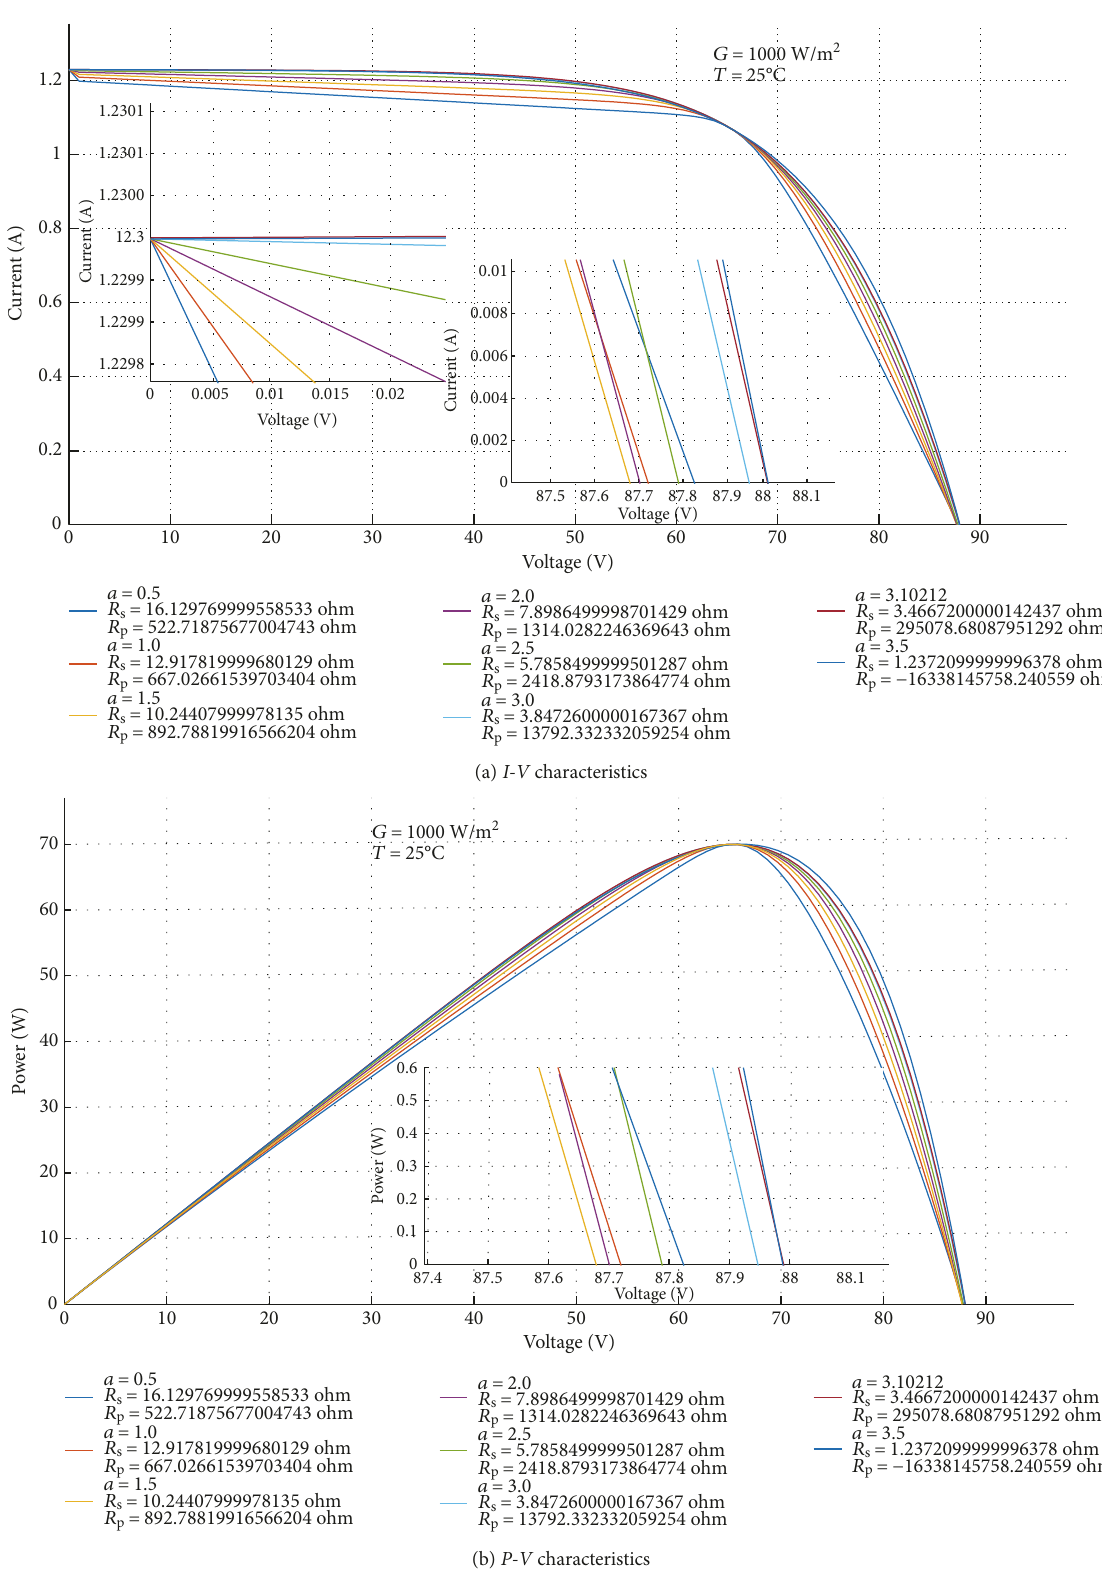
and the corresponding values of R STC